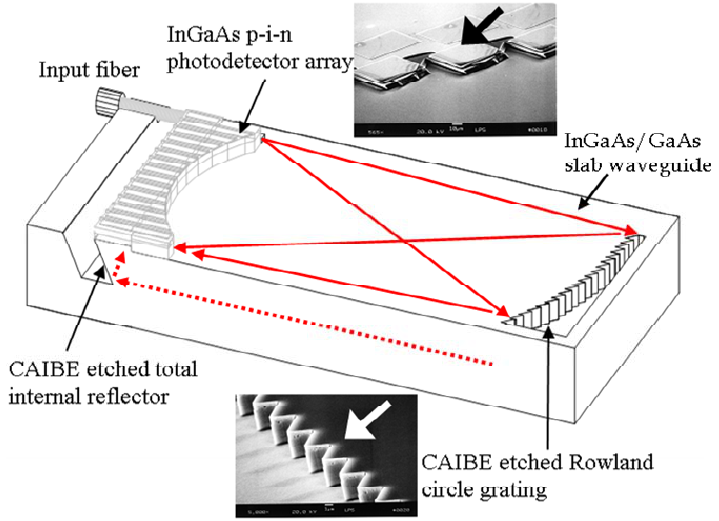
Figure 5. A schematic is the diagram that represents the WDM photodetector module. The insets are the scanning electron microscope (SEM) pictures for grating teeth and the photo-detector array with TIR mirrors